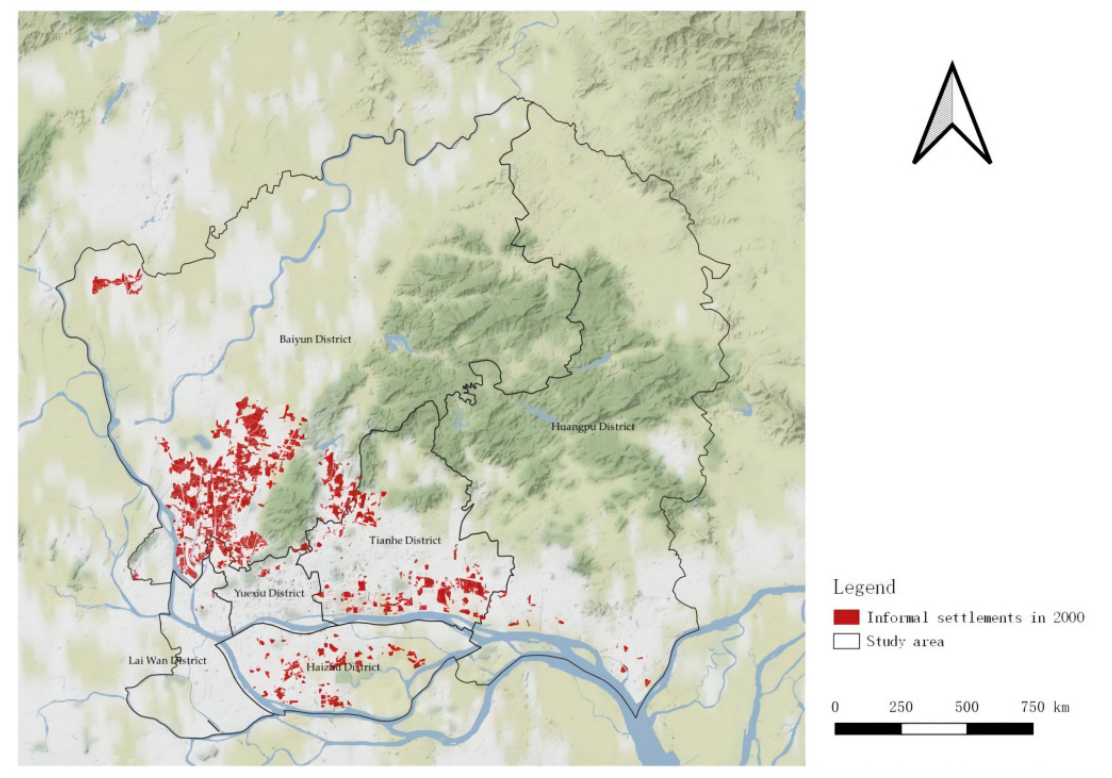
Figure 5. The spatial distribution characteristics of informal settlements in 2000. Source: drawn by the authors. The background image is from the Stamen map.